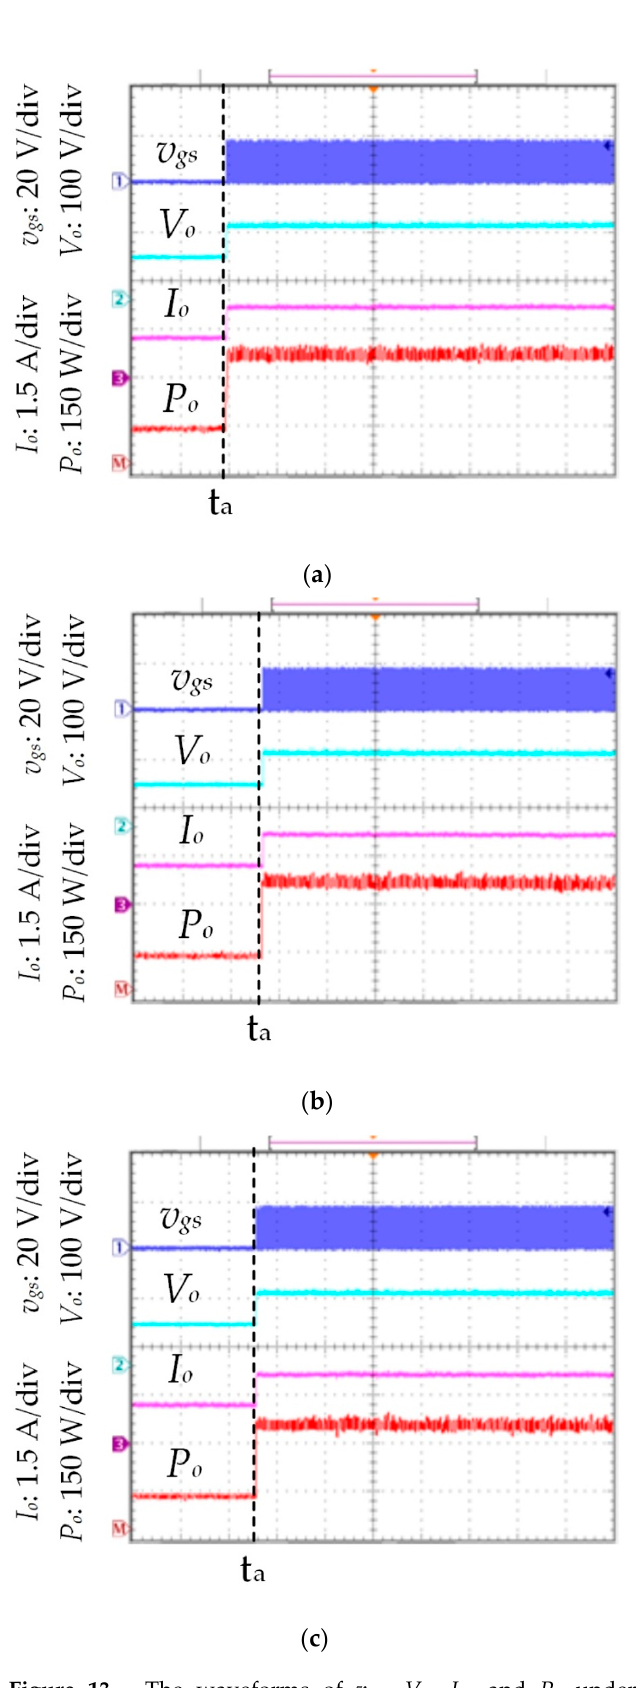
Figure 13. The waveforms of v gs , V o , I o , and P o under UIC with IL = 700 W/m 2 and temperature = 25 °C by implementing the control strategy ( a ) SLOPDM, ( b ) SAH, and ( c ) P&O algorithms. (Horizontal axis: 2 s/div).